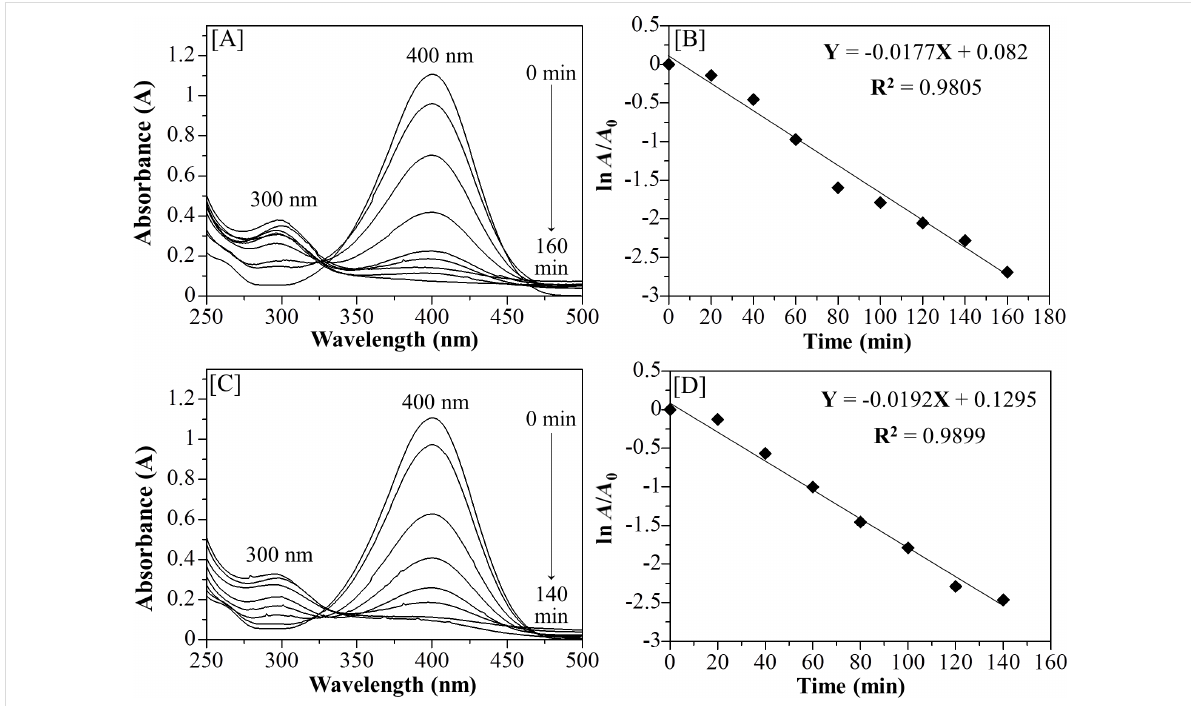
Figure 9: UV–vis absorption spectral changes for the reduction of 4-NP at 20 min intervals over a) [AuNPs] cal /silica hex film at 250 °C with b) a corre- sponding graph of ln A / A 0 versus time within 160 minutes. c) The [AuNPs] red /silica hex film at 210 °C with d) a corresponding graph of ln A / A 0 versus time within 140